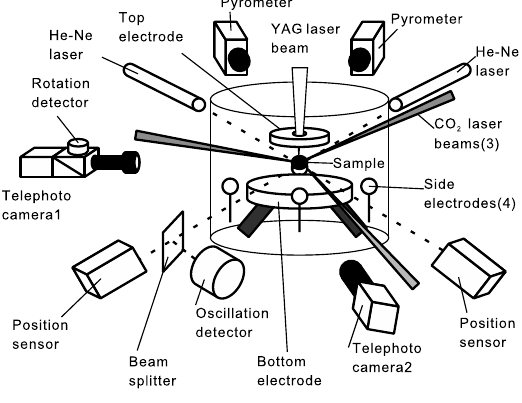
Figure 11. Optical layout of an electrostatic levitation furnace (ELF) used at the Japan Aerospace Exploration Agency (JAXA). YAG: yttrium aluminum